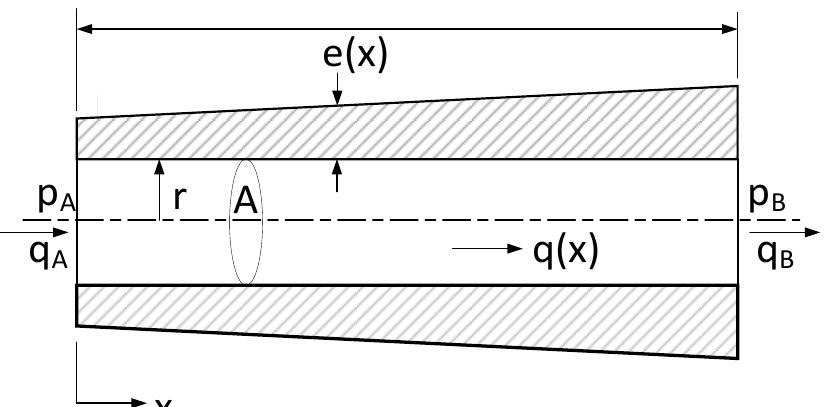
Figure 1. Flow through a circular tube with varying wall thickness and, consequently, varying wave propagation velocity. (Wall thickness and diameter are exaggerated.)